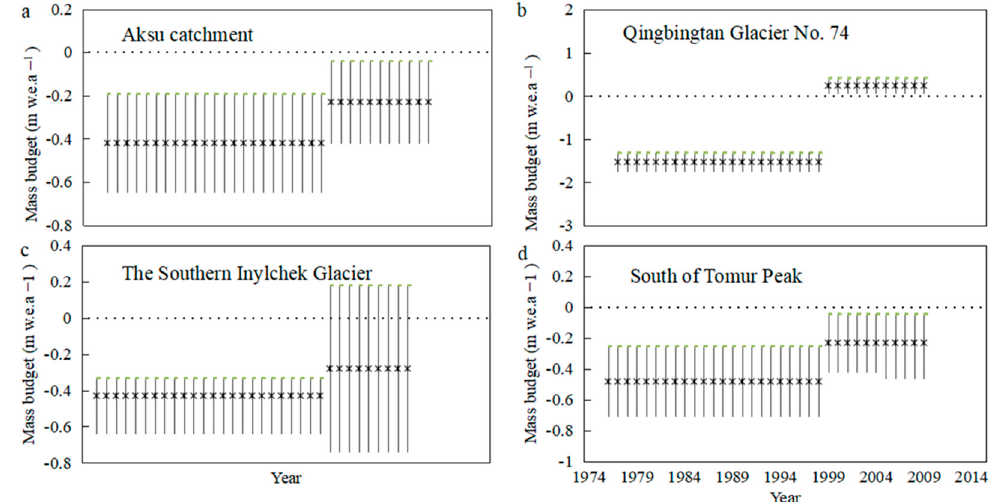
Figure 11. Glacier mass budgets for ( a ) Aksu catchment [76], ( b ) Qingbingtan Glacier No. 74 [112], ( c ) Southern Inylchek Glacier [107], and ( d ) South of Tomur Peak [114].